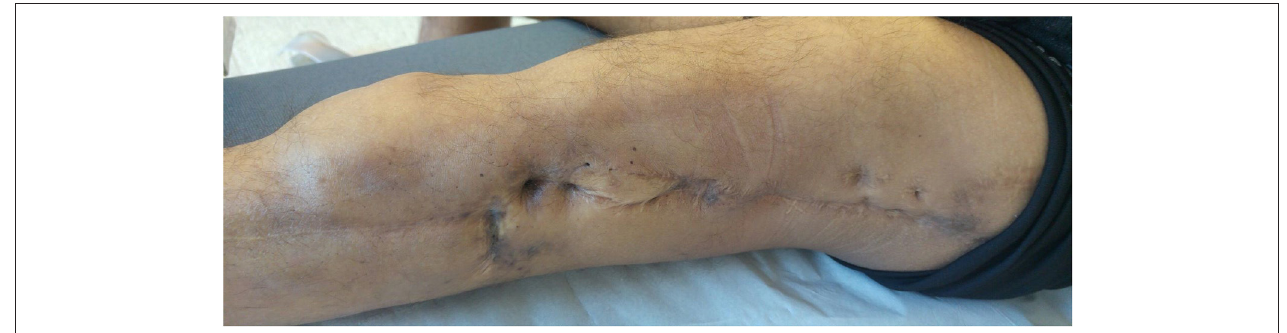
FIGURE 1 | Pre-operative left lower limb lateral side skin status with multiple retractile scars.